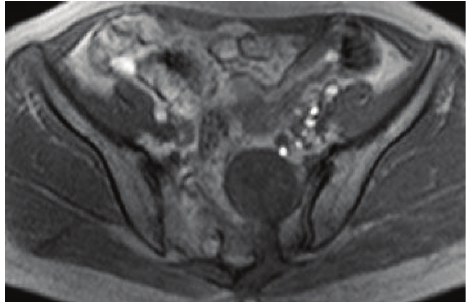
Figure 5: Axial T1-weighted MR image demonstrates dumbbell- shaped tumor which arising from sacral foramen and extended anteriorly to pelvic cavity in patient no. 4.